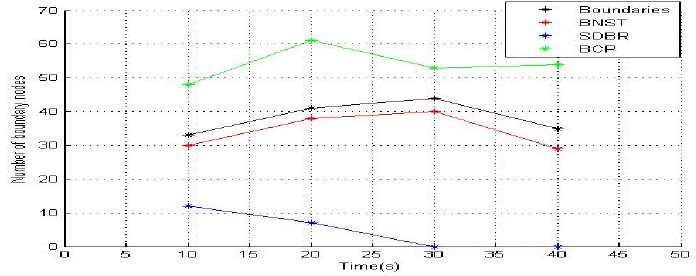
Figure 9. Boundary nodes recognized by BNST, SDBR, and BCP.